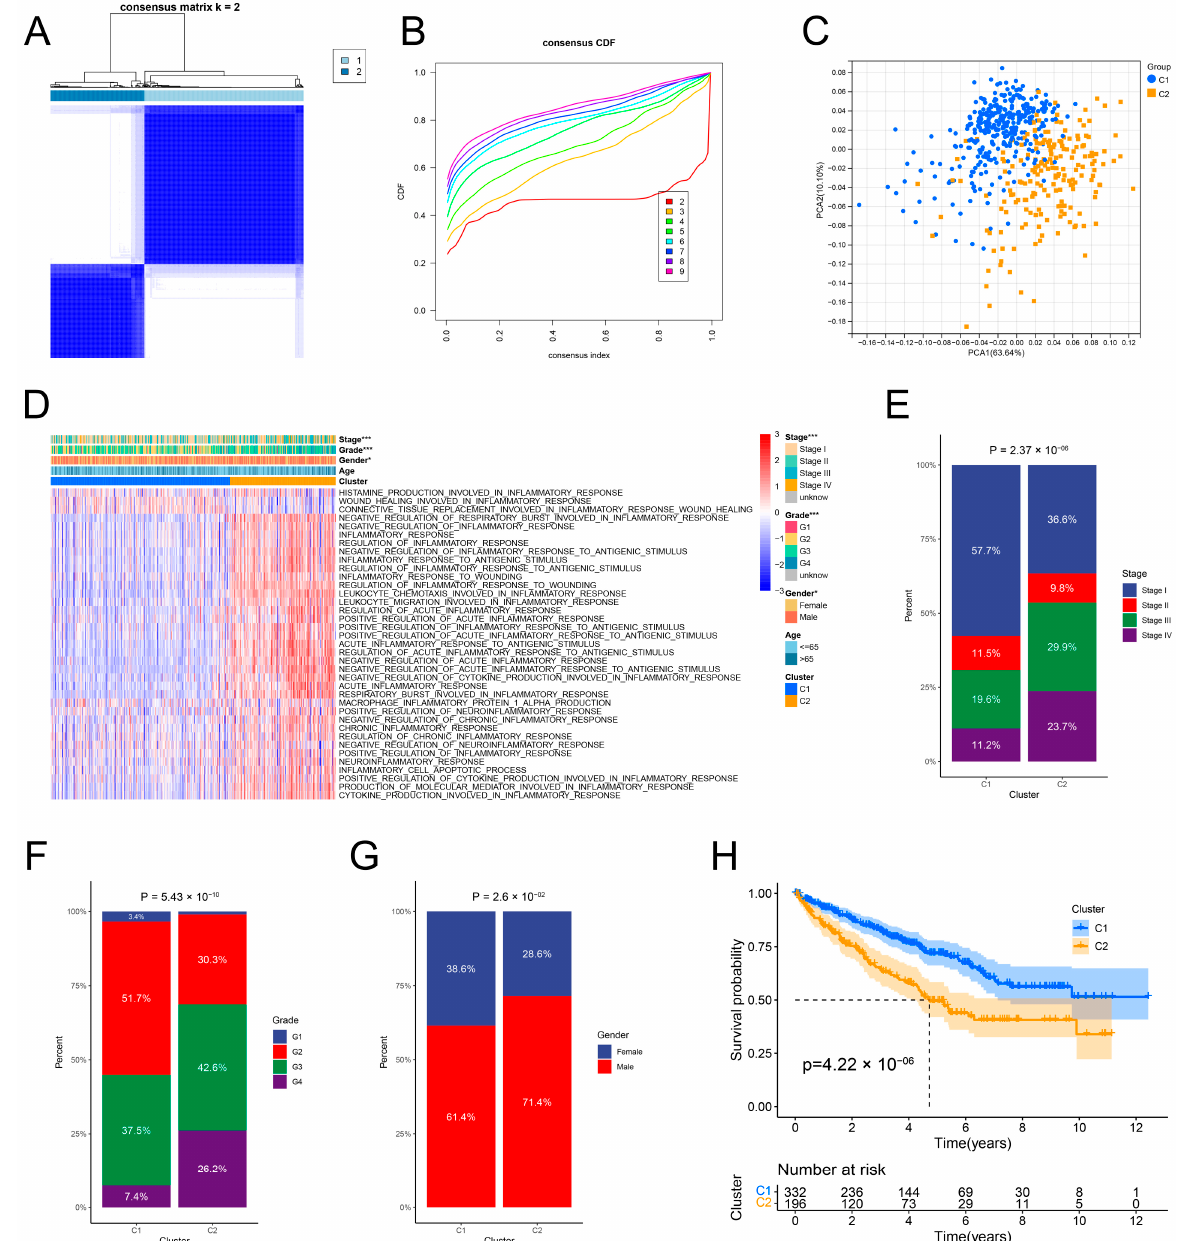
Figure 2. Identification of inflammation clusters of ccRCC based on inflammation-related signatures. ( A ) Consensus cluster matrix for k = 2. ( B ) CDF curves for k = 2–9. ( C ) PCA for two inflammation clusters. ( D ) Functional enrichment of 37 inflammation-related BP terms and distribution of clinical parameters between two inflammation clusters. ( E – G ) The two inflammation clusters differ in the proportions of the tumor stage, tumor grade, and gender components. ( H ) OS of the two inflammation clusters. * p < 0.05; and *** p < 0.001.